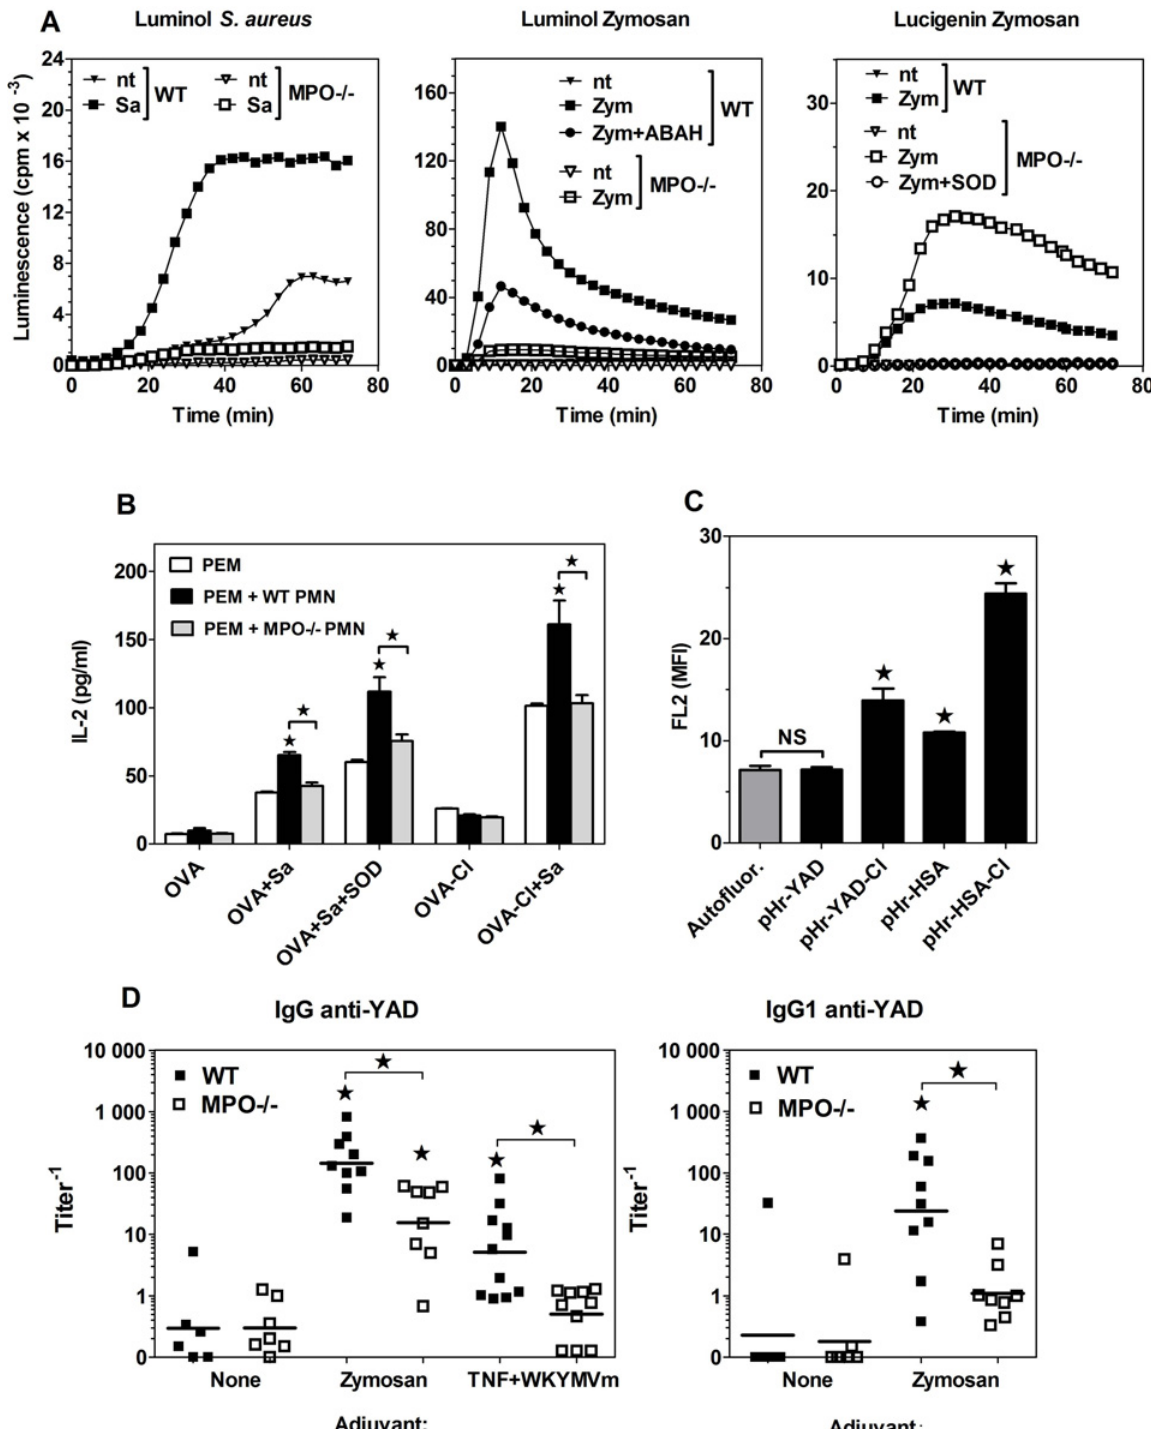
Fig 6. Immunogenicity of proteins is enhanced as the result of oxidation by endogenous, neutrophils-derived HOCl. ( A ) Luminol- or lucigenin- enhanced chemiluminescence stimulated by zymosan (Zym) or heat-killed S . aureus (Sa) in WT and MPO-/- neutrophils. ( B ) Presentation of OVA, as assessed by IL-2 production, by PEM pre-incubated with OVA, S . aureus and WT or MPO-/- neutrophils (PMN) to subsequently added CD4 + OT-II lymphocytes. ( C ) Uptake of pHrodo-labelled native or HOCl-oxidised YAD or HSA by BM-DC, assessed by flow cytometry. Results of single experiments shown were repeated 2 more times with similar results. ( D ) Titers of YAD-specific IgG in sera of mice primed with 20 μ g YAD and hot alkali-treated zymosan